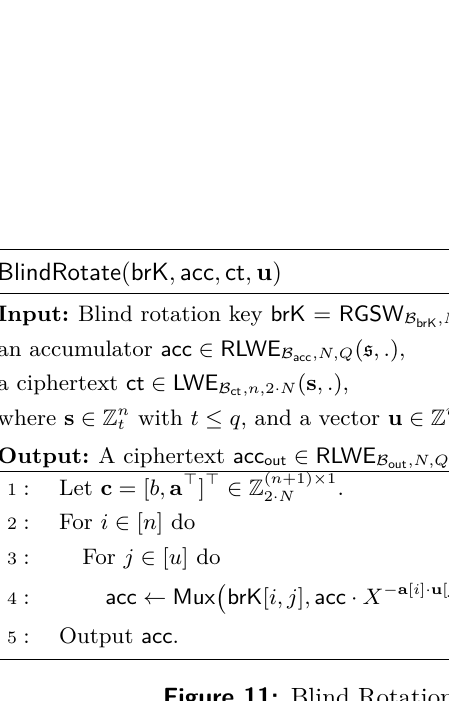
Figure 11: Blind